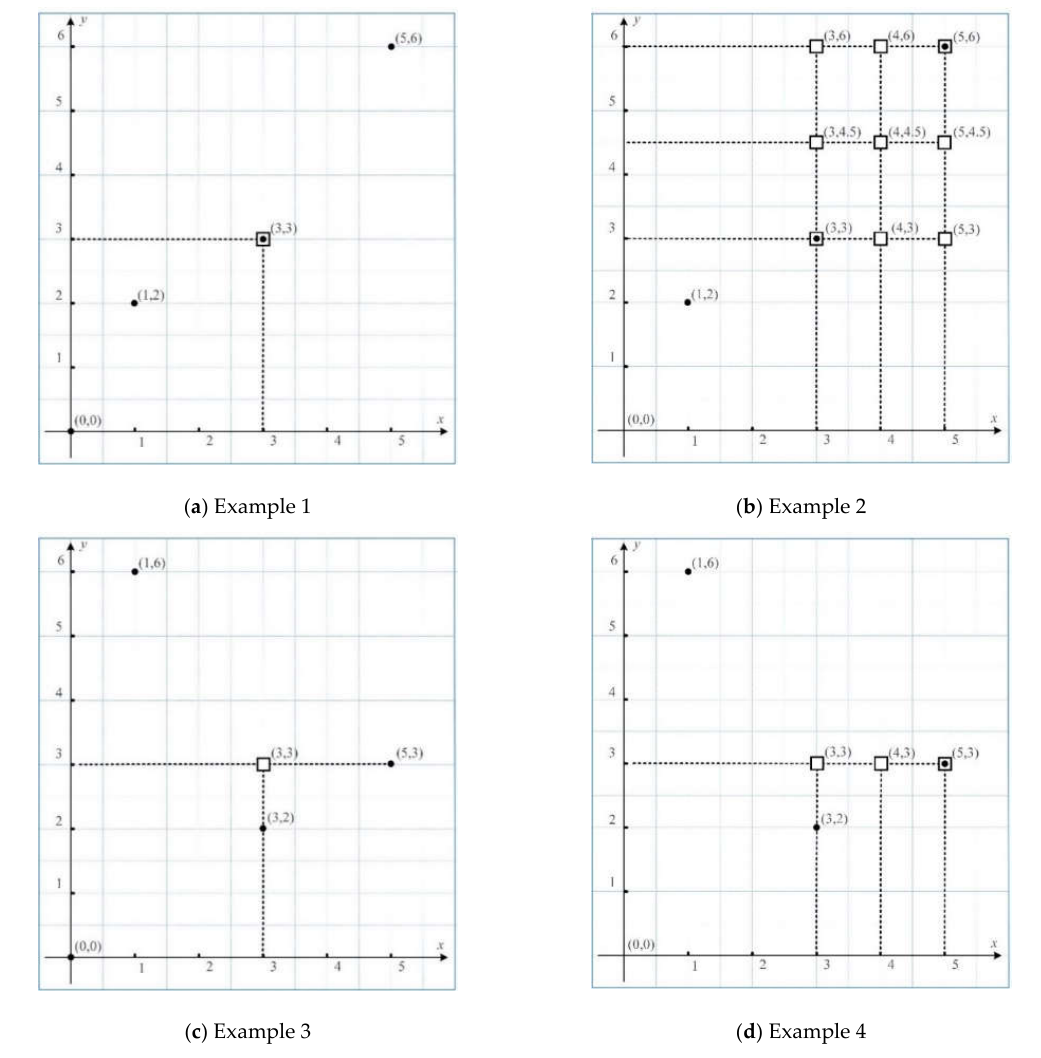
Figure 1. Candidate locations for the facility. ( a ) Example 1; ( b ) Example 2; ( c ) Example 3; ( d ) Example 4.